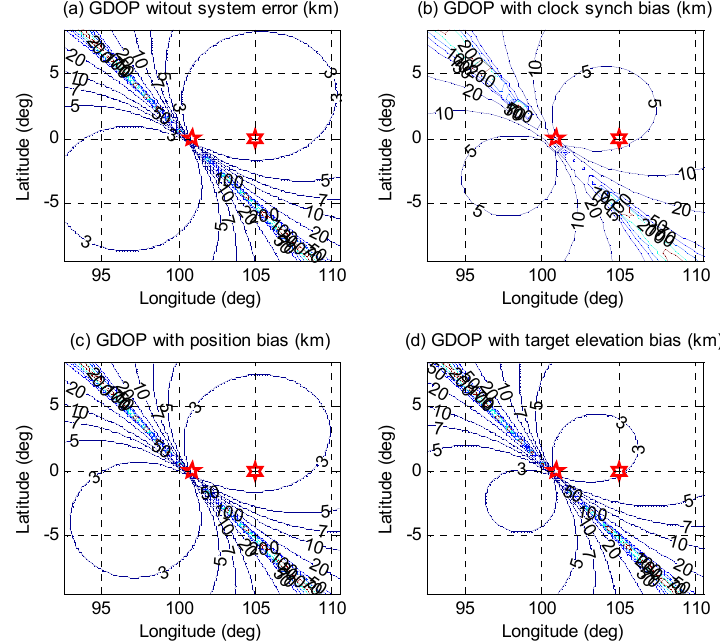
Figure 1. GDOPs of position estimation using the GEO and LEO satellites.